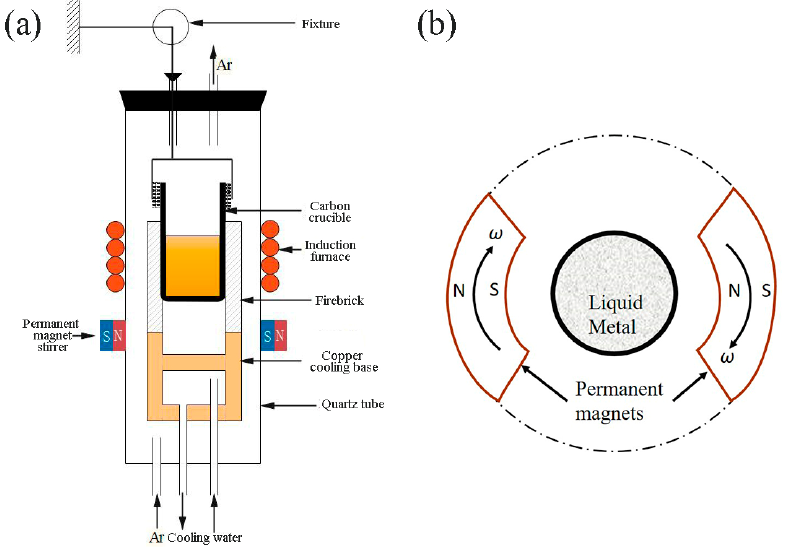
Figure 1. Schematic drawing of the experimental apparatus ( a ). Principle diagram of the magnetic field generated by a pair of NdFeB permanent magnets ( b ).